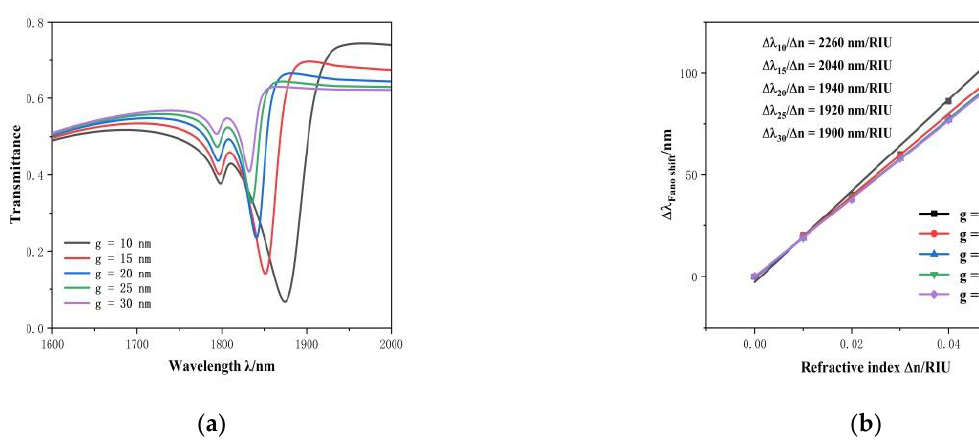
Figure 8. ( a ) Transmission spectra for various coupling gaps g between the CCDRR and waveguide; ( b ) shifts of the dip point in Fano resonance ( Δλ ) with a changed refractive-index ( Δn ).